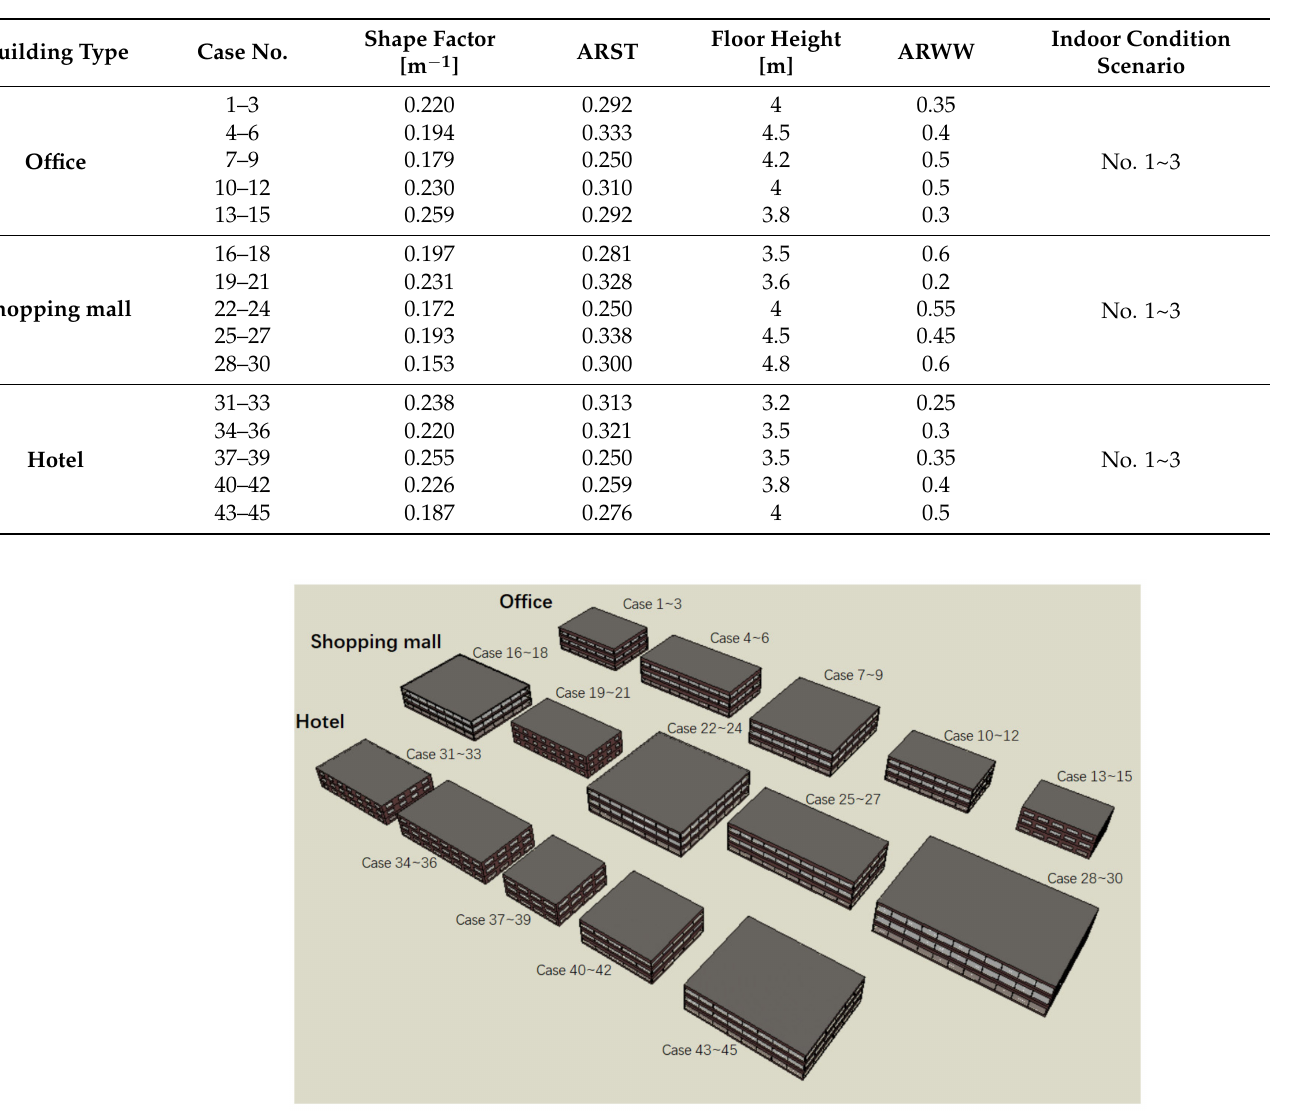
Table 6. Model parameters of 45 test cases.